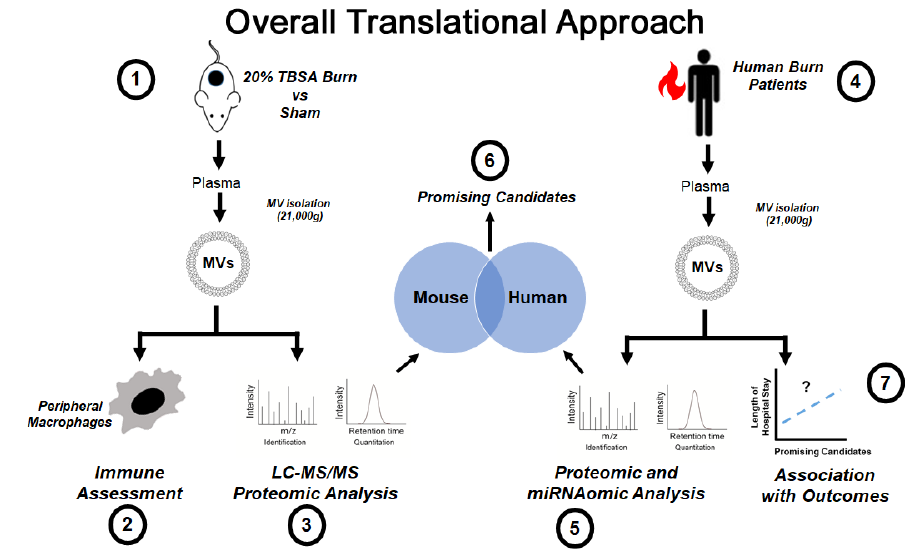
Figure 1. Overall Translational Experimental Design. (1) Mice undergo a 20% total body surface area (TBSA) burn injury, and EVs isolated within 72 h after injury. (2) Mouse burn EVs are tested for pro-inflammatory capacity in mouse splenic macrophages. (3) Mouse burn EVs are assessed for protein content using LC-MS/MS proteomic analysis. (4) EVs are isolated from human burn patients with severe burn injury. (5) Proteomic and miRNAomic analysis of human EVs is performed. (6) Proteomic profiles of human and mouse burn EVs are compared, and promising candidates identified. (7) Promising candidates were measured in a larger cohort of human burn patients and associated with length of hospital stay.